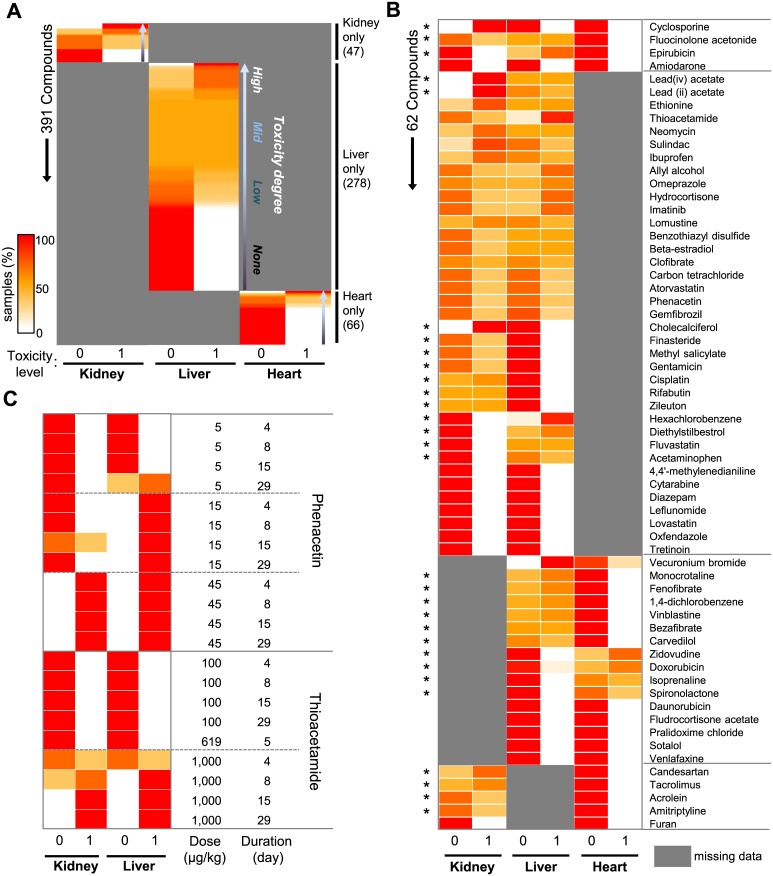
Characterization of pharmacogenomics meta-data.(A) Distribution of toxicity levels for 391 compounds from single-organ studies. Compounds were rank-ordered by relative toxicity level. (B) Distribution of toxicity levels for 62 compounds from multi-organ studies. Asterisks indicate compounds showing organ-specific toxicity. (C) Distribution of toxicity levels for two selected drugs at different doses and treatment durations. The same color scale is used in all panels. Missing information is shown in grey. For each row, the sum of samples with level-0 and level-1 toxicity per each organ is 100%. See S5 Table for the exact values used to generate this figure.